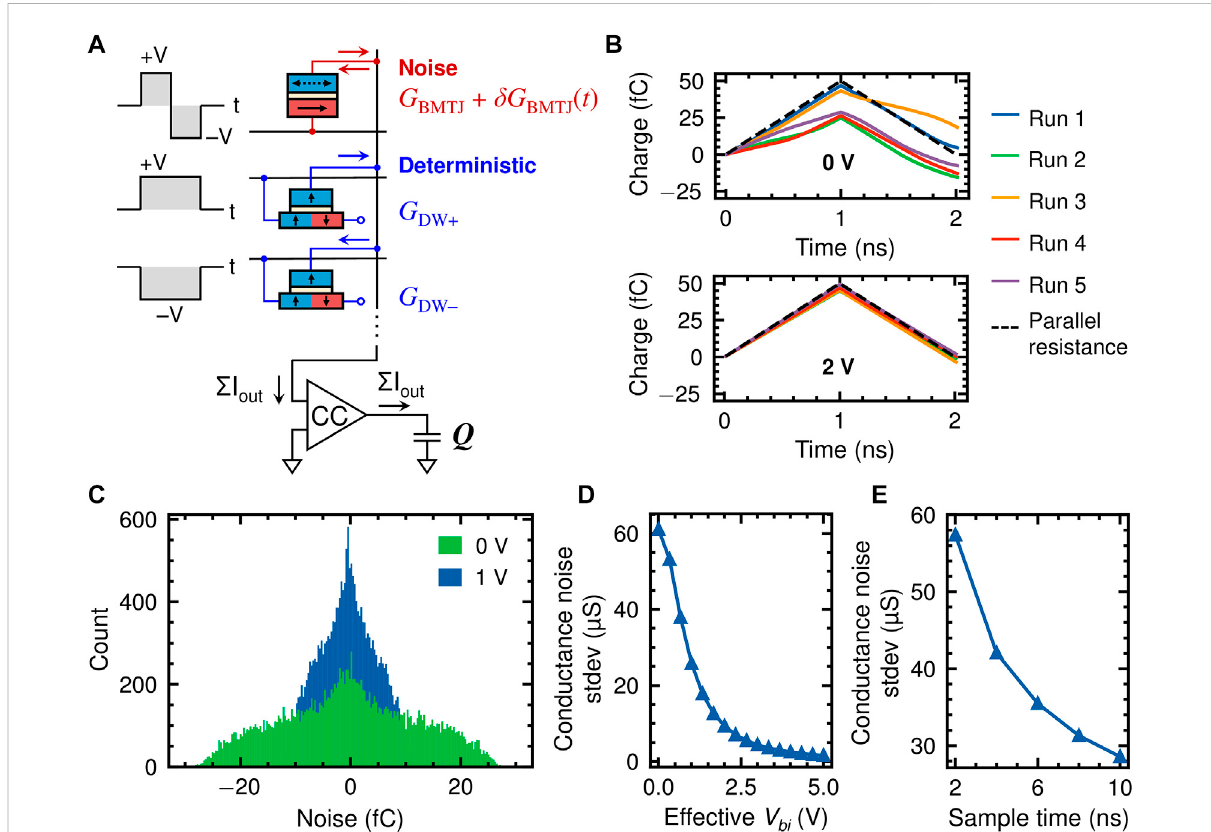
FIGURE 2 (A) Probabilistic cell with one Bayes-MTJ and two DW-MTJ devices to encode a programmable Gaussian distribution. The third DW-MTJ terminal is used only during programming. Currents on a column are integrated on a capacitor. (B) Charge on the capacitor Q vs. time due to the Bayes-MTJ current at two values of V bi . Each run is an independent read using a 2 ns bipolar volage pulse. (C) Distribution of the fi nal capacitor charge Q ( T =2ns)inducedbynoiseintheBayes-MTJ,attwovaluesof V bi with20,000sampleseach. (D) Standarddeviationof Q ( T =2ns)vs. V bi on the Bayes-MTJ, (E) Q ( T ) vs. the total pulse length T at V bi =0